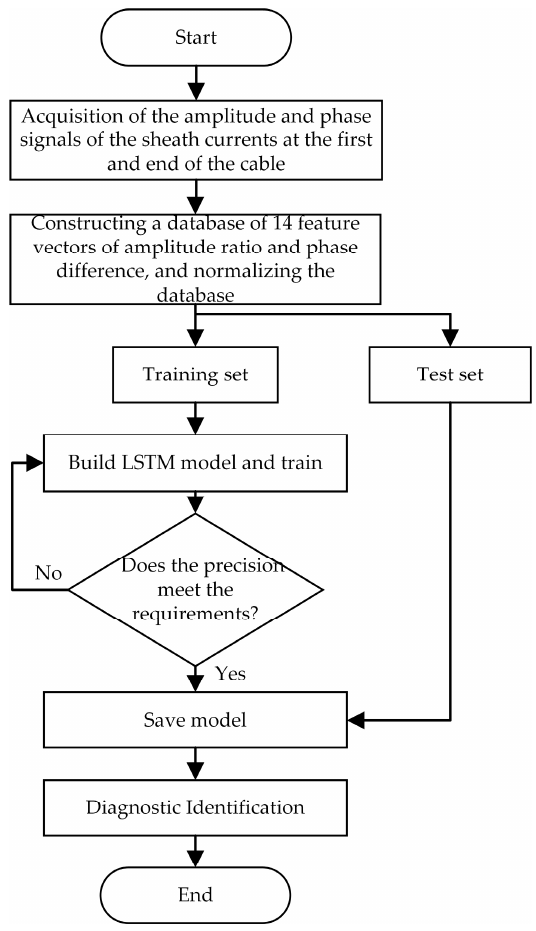
Figure 11. Flow chart of cable grounding system fault diagnosis based on LSTM.